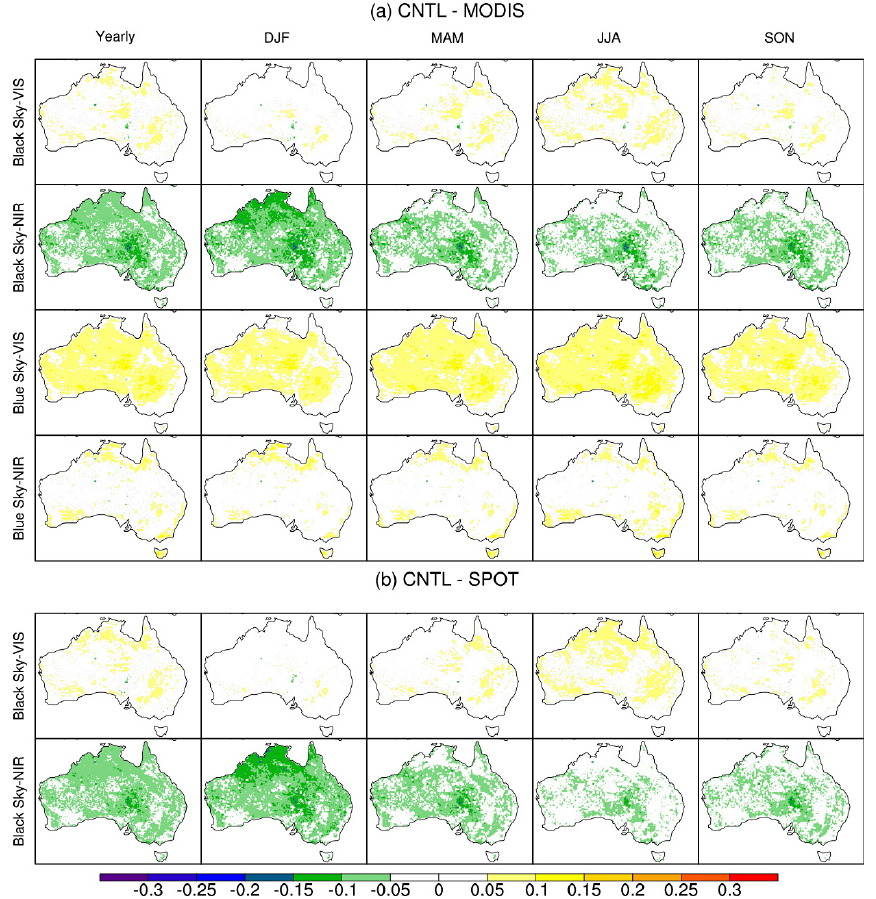
Figure 5. Mean yearly and seasonal differences between (a) CNTL and MODIS albedo (CNTL-MODIS) and (b) CNTL and SPOT albedo (CNTL-SPOT) over the period 2001–2008. December-January-February (DJF) is summer; March-April-May (MAM) is autumn; June-July- August (JJA) is winter; September-October-November (SON) is